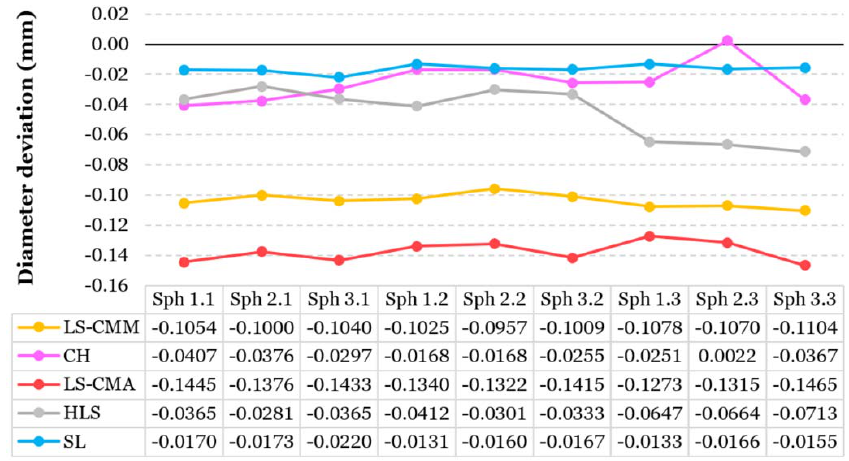
Figure 7. Deviation of sphere diameters for the optical measurements (OMS) from the reference values (CMM).